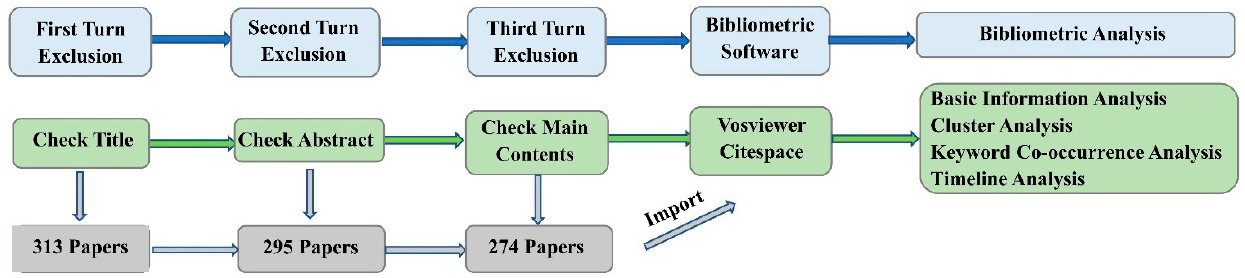
Figure 2. Bibliometric analysis method.